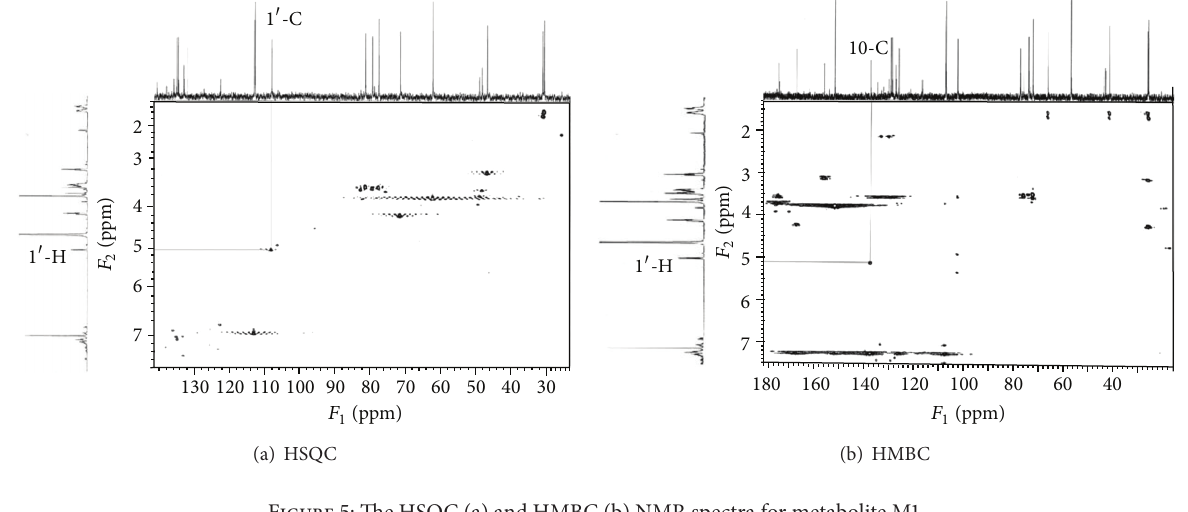
Figure 5: The HSQC (a) and HMBC (b) NMR spectra for metabolite M1.